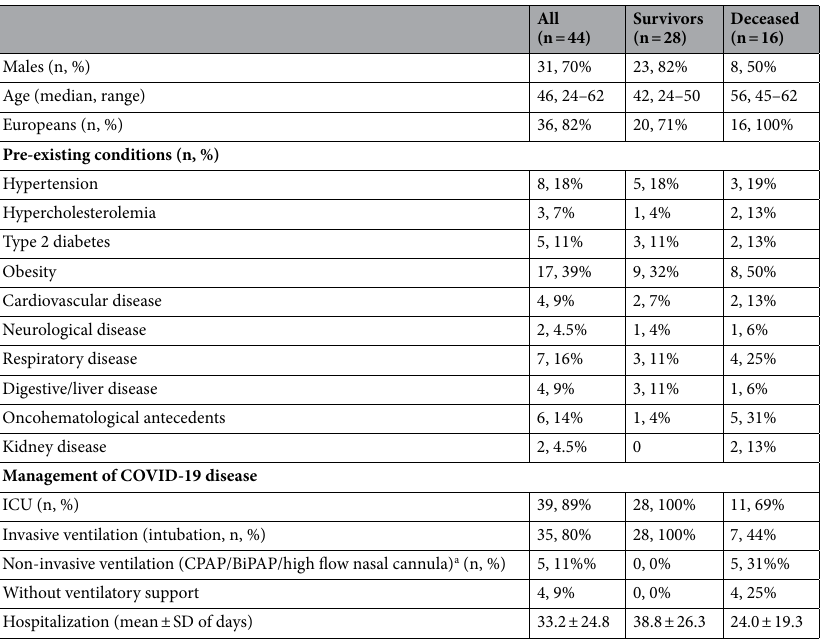
Table 1. Clinical and demographic characteristics. a Patients that received exclusively non-invasive ventilatory support.